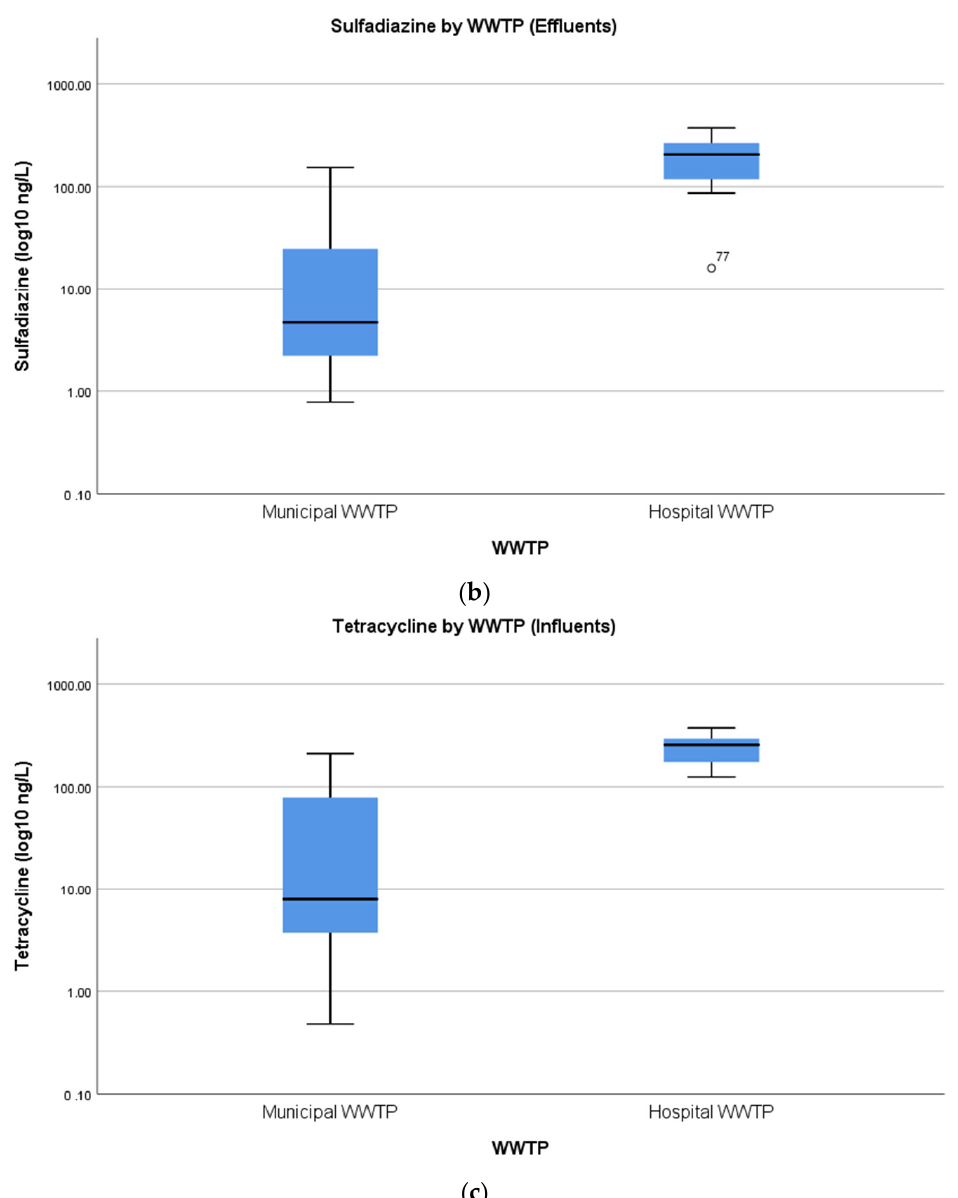
Figure 7. Differences in sulfadiazine ( a , b ) and tetracycline ( c ) concentrations in influent and effluent hospital and municipal WWTPs (values in ng/L are reported on a log10 scale). Results of the independent t -tests are illustrated in the supplementary material (Tables S12–S18).